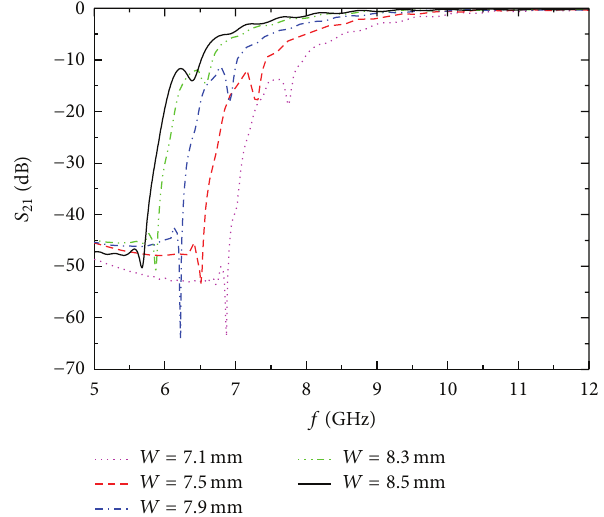
Figure 2: Simulated 𝑆 21 of the antenna for different aperture